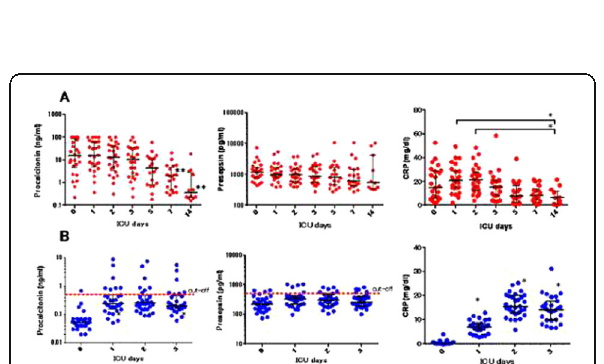
Fig. 2 (abstract 0120). Chronological changes in procalcitonin, presepsin and CRP in septic group and non-septic surgical group. A: Data of septic group, B: Data of non-septic surgical group.